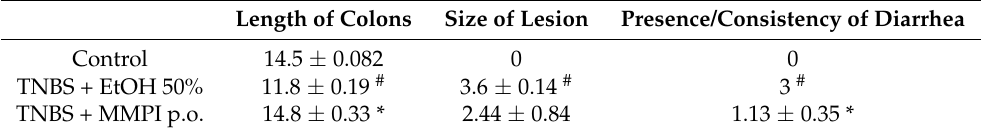
Table 1. Morphological and functional observations in clean and transversely opened colons after harvest. Effect of the L. albus MMPI administration on the length of colon (cm). Sham group ( n =